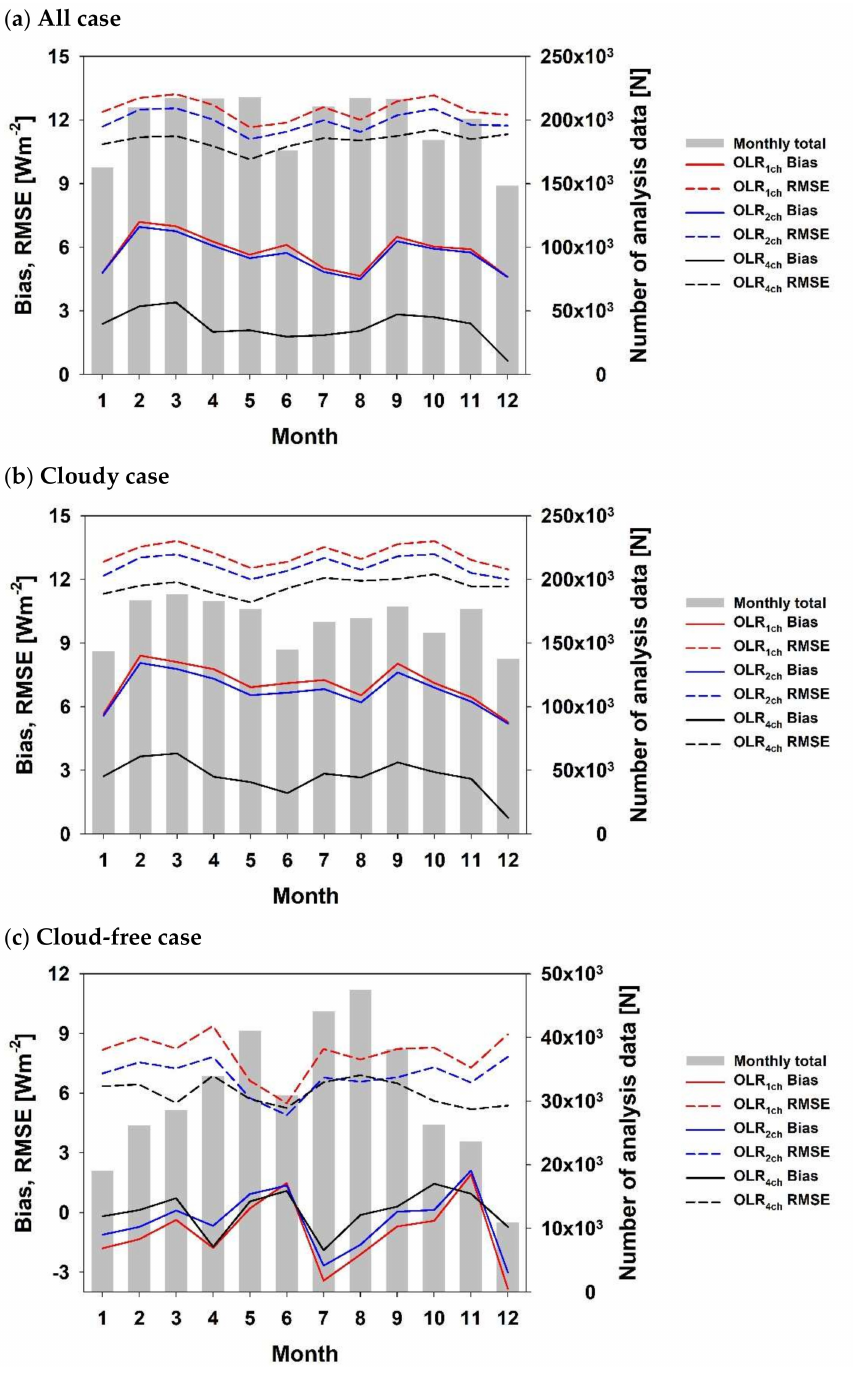
Figure 6. Bias and RMSE of calculated AHI OLR and CERES OLR for each monthly case in 2017 and the number of cases